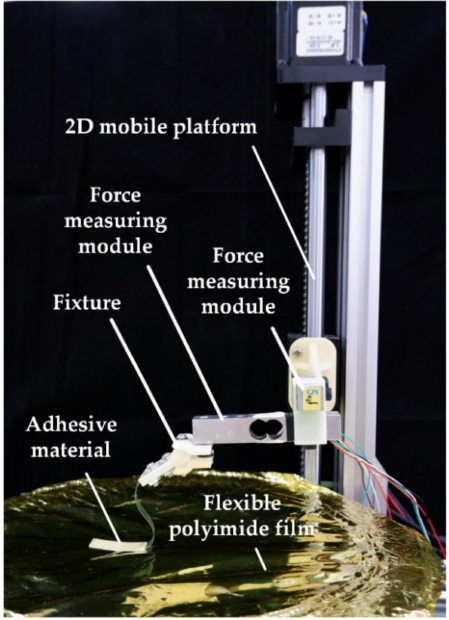
Figure 8. Desorption experimental